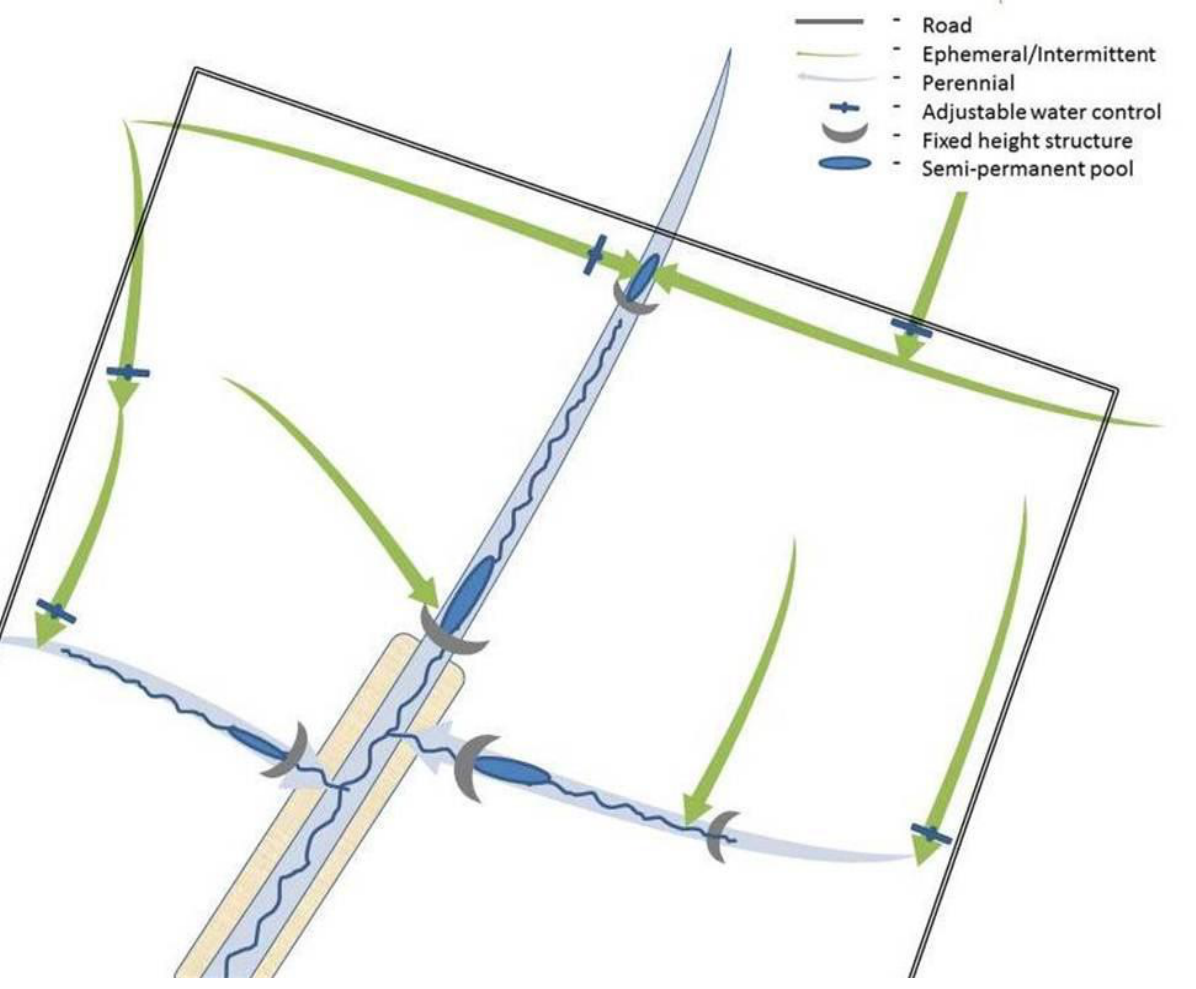
Figure 6. Schematic showing a hypothetical hierarchical arrangement for in-stream practices at the field scale (approximately 0.25 hectares). Ditch and structure width is exaggerated for illustrative purposes. Small, adjustable water control devices, such as the flashboard risers or slotted concrete weirs are situated in smaller ditches along the perimeter road for easy access. Non-adjustable low-grade impediments are placed at regular intervals along the reach and upstream of confluences. These devices can be log vanes, armored berms, or simply artificial riffles. Ideally, they are placed downstream of shallow pools and empty into a two-stage or naturally meandering